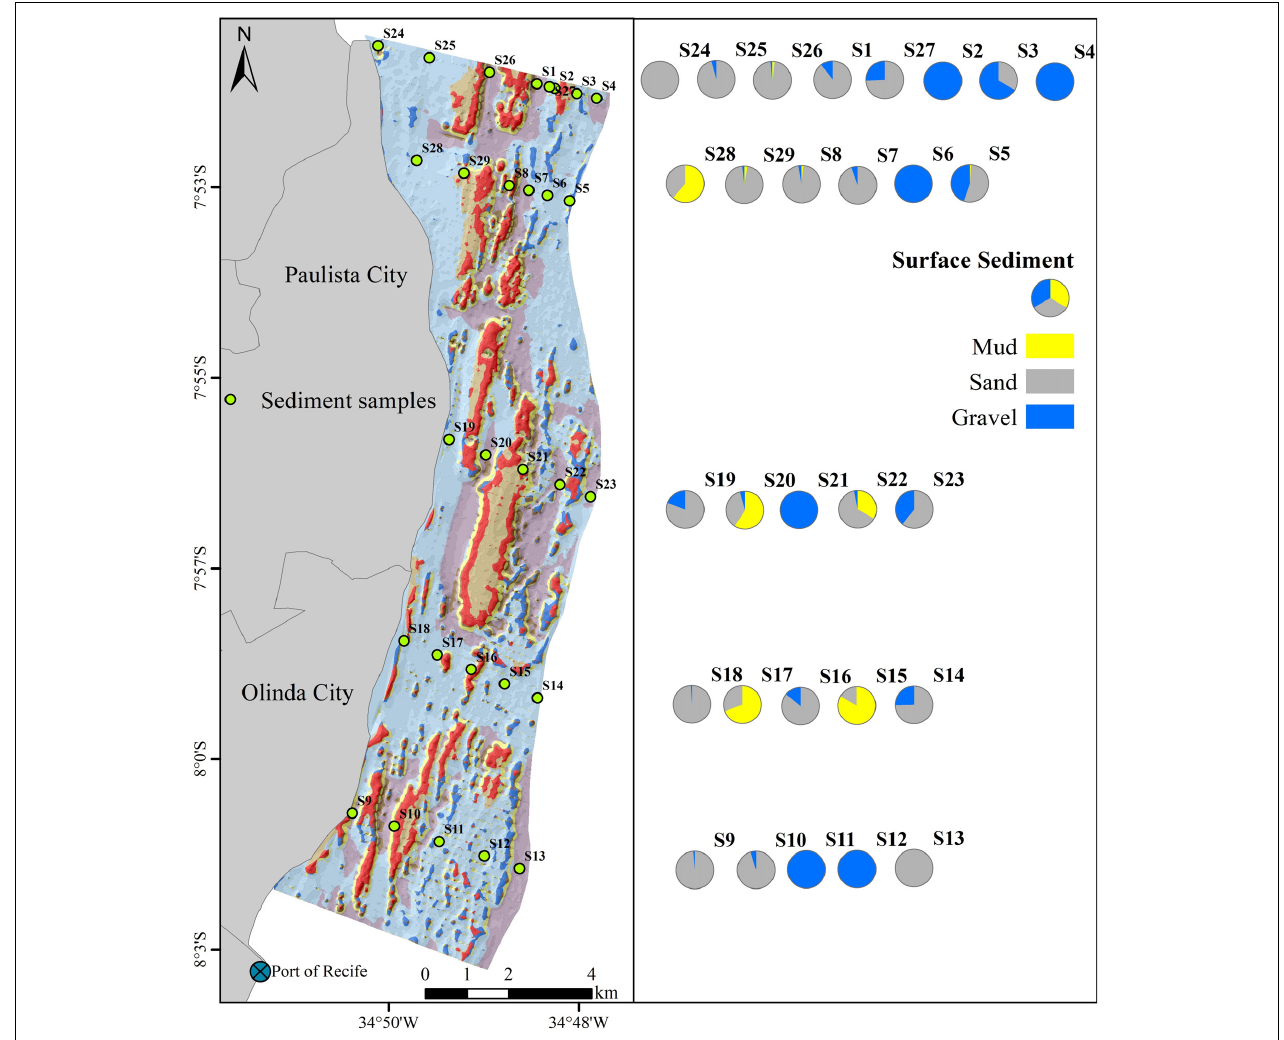
FIGURE 4 | Spatial variability in the percentages of mud, sand and gravel contents in surface